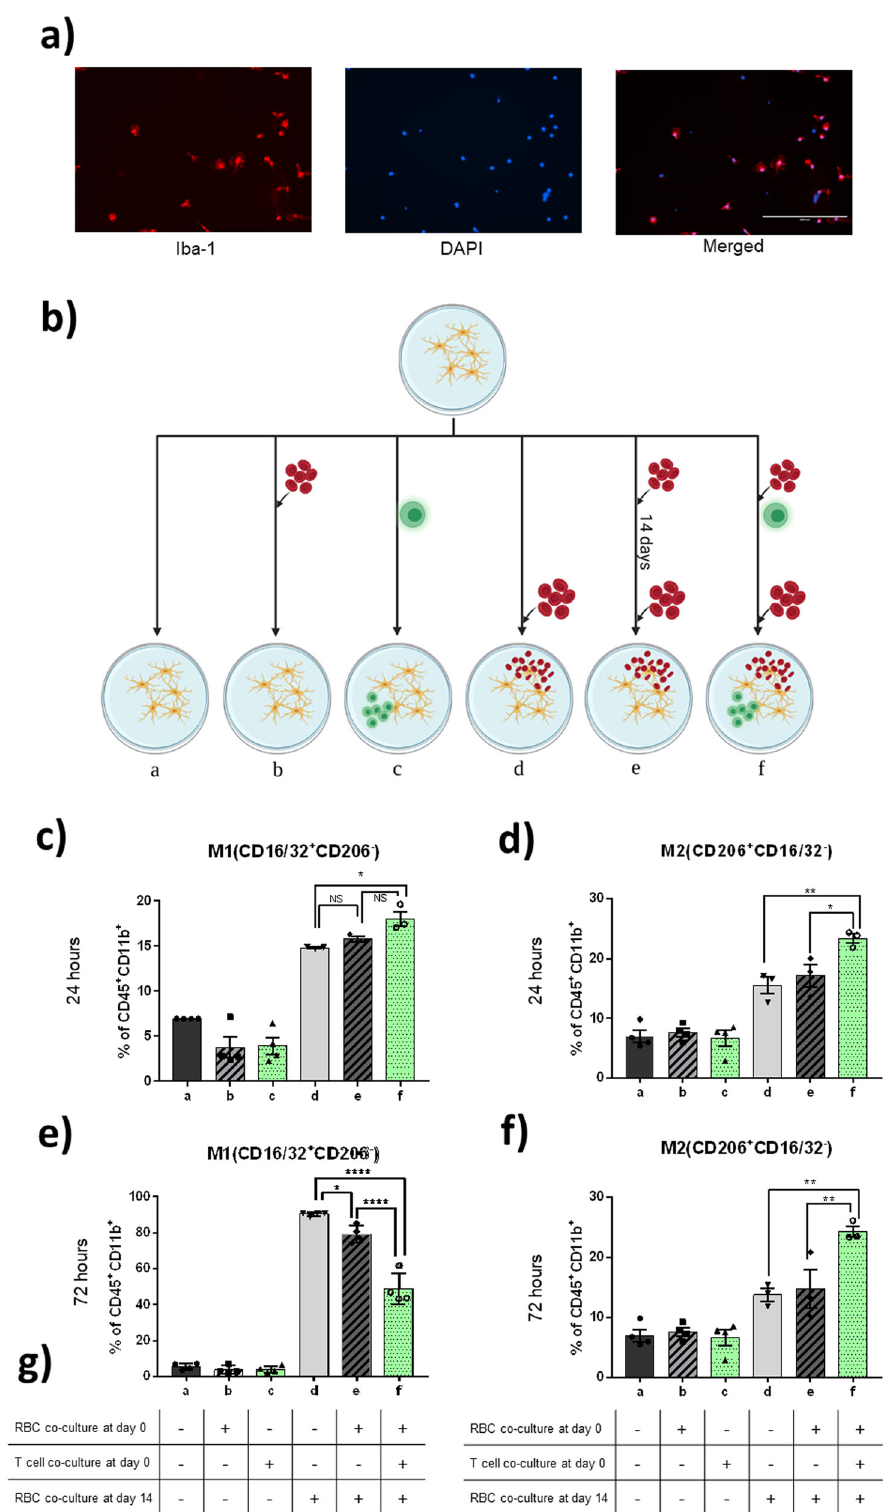
During our erythrophagocytosis study, when fl uorescent-labeled RBCs were added to microglia, the percentage of intracellular RBCs was highest in Group F (with T cells and a previous RBC coculture), second in Group E (with a previous RBC coculture) and lowest in Group D (RBC-naive microglia) (Fig. 6). This indicates superior RBC phagocytic abilities in microglia with a previous stimulus, which is enhanced by the presence of T